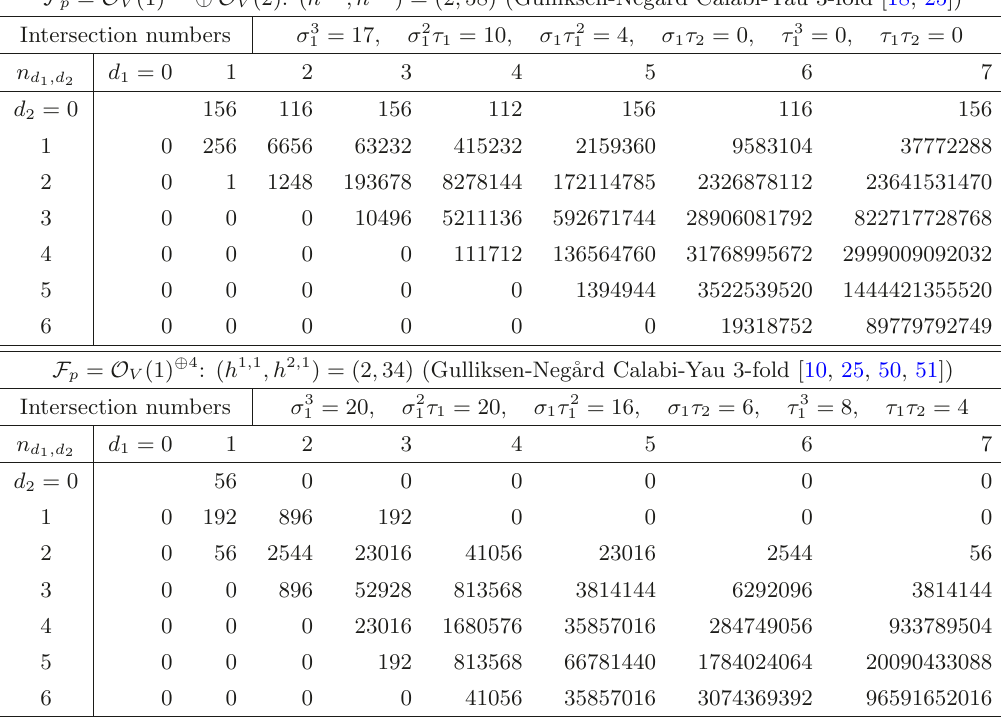
Table 5 . Genus-0 invariants of determinantal 3-folds in (2.23) with V = P 7